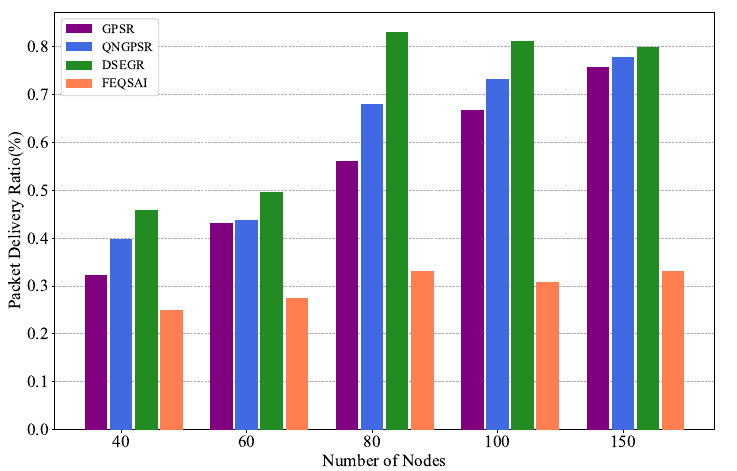
Figure 9. Performance comparison of the PDR among GPSR, QNGPSR, DSEGR, and FEQSAI with different node